Question: Looking at the figure, what chart type is it?
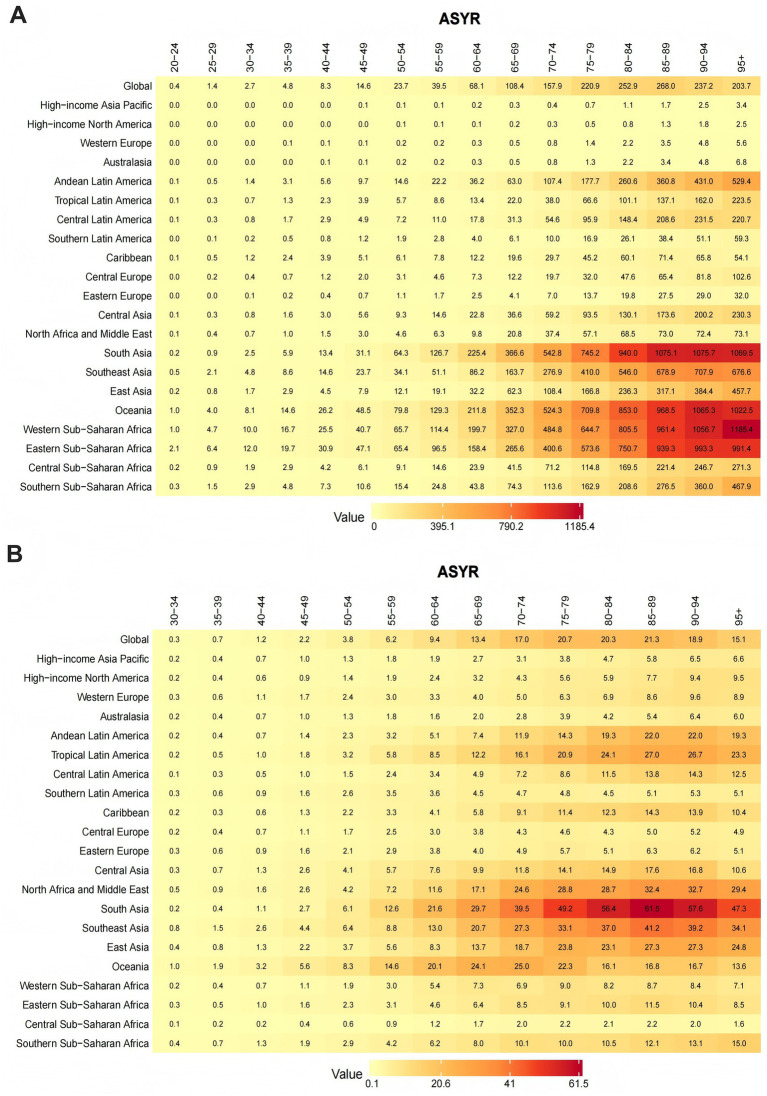
Answer: heatmap